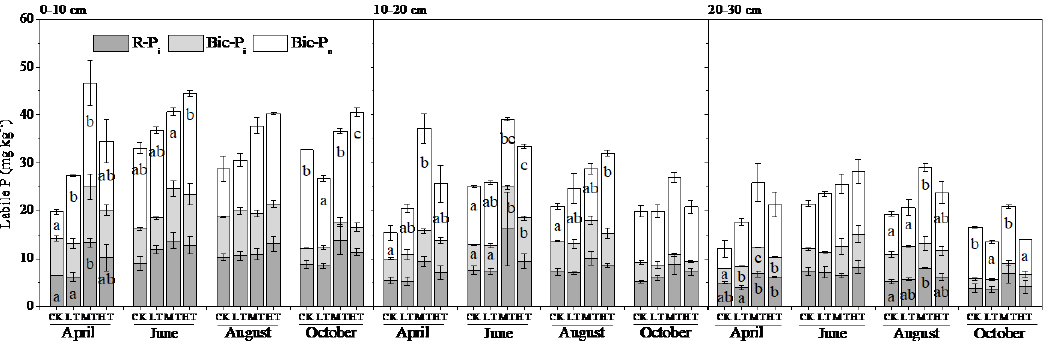
Figure 4. Response of labile P fractions to thinning treatments at the three depths (0 − 10, 10 − 20 and 20 − 30 cm) at various sampling times in L. principis-rupprechtii plantations. CK, control site; LT, light thinning; MT, moderate thinning; HT, high thinning. Error bars indicate standard error ( n = 3). Values within each sampling time followed by different letters differ significantly according to Tukey's test ( p <0.05). When the difference was not statistically significant, no letter notation was noted.